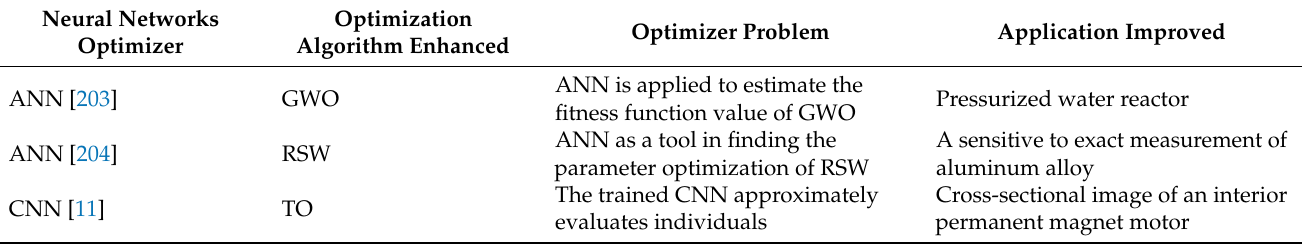
Table 11. Studies involving neural networks for improving optimization techniques design and application